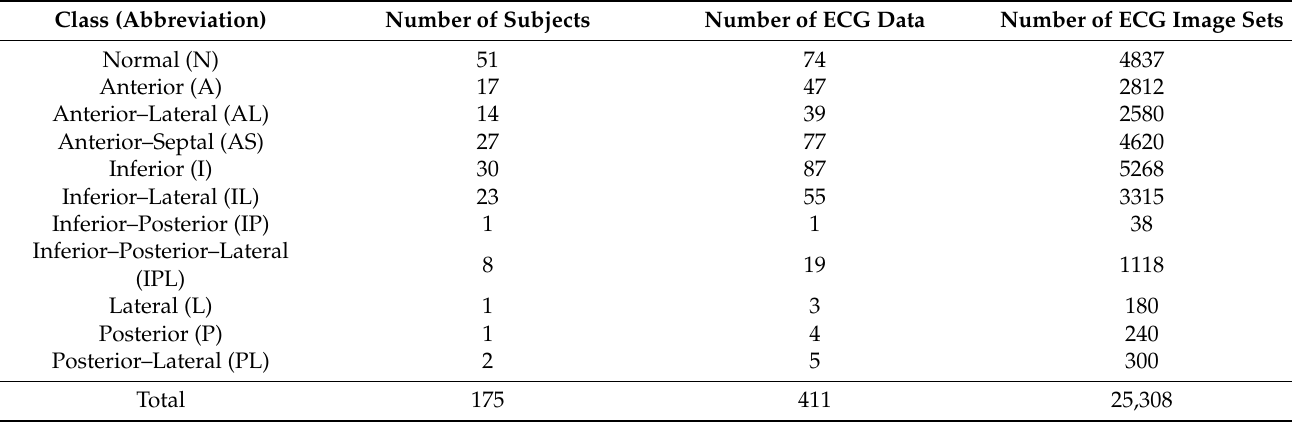
Figure 1. Creation of ECG image sets. Table 1. Details of ECG image set for each class.